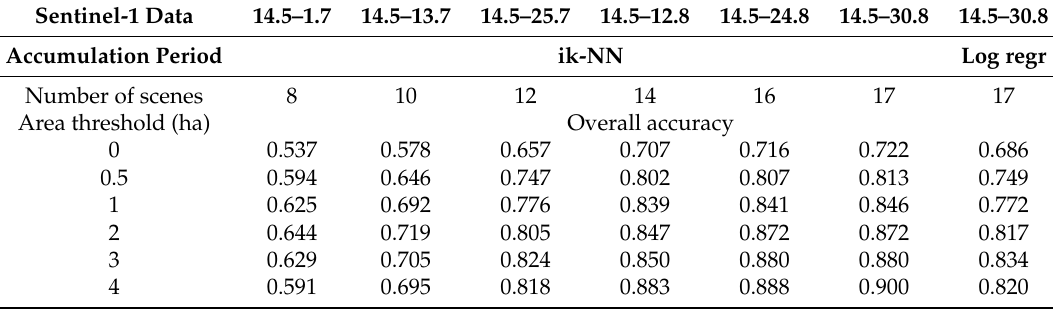
Table 4. Overall accuracies with the ik-NN method, maximum 17 Sentinel-1 scenes from the period 14 May–30 August, ascending geometry VV and HV polarizations, and with multinomial logist regression (Log regr), nine species groups, the minimum area of the parcel varies from 0 ha to 4